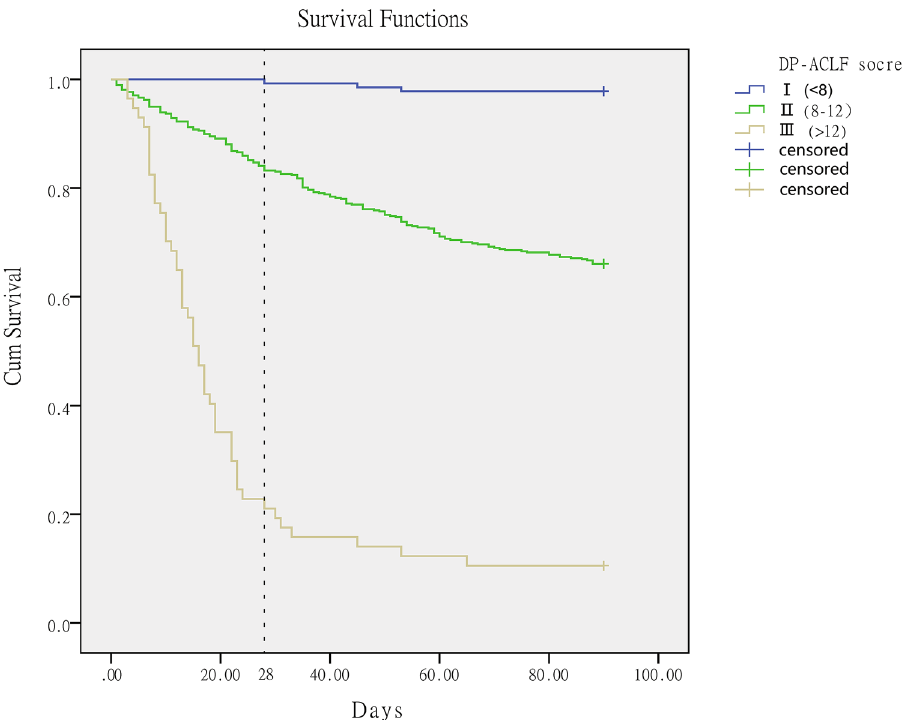
Figure 7. Kaplan–Meier survival analysis showing a significant difference in 28-day ( χ 2 = 238.411, p < 0.001) and 90-day cumulative survival rates ( χ 2 = 270.194, p < 0.001) in patients with ACLF who were graded according to the DP-ACLF